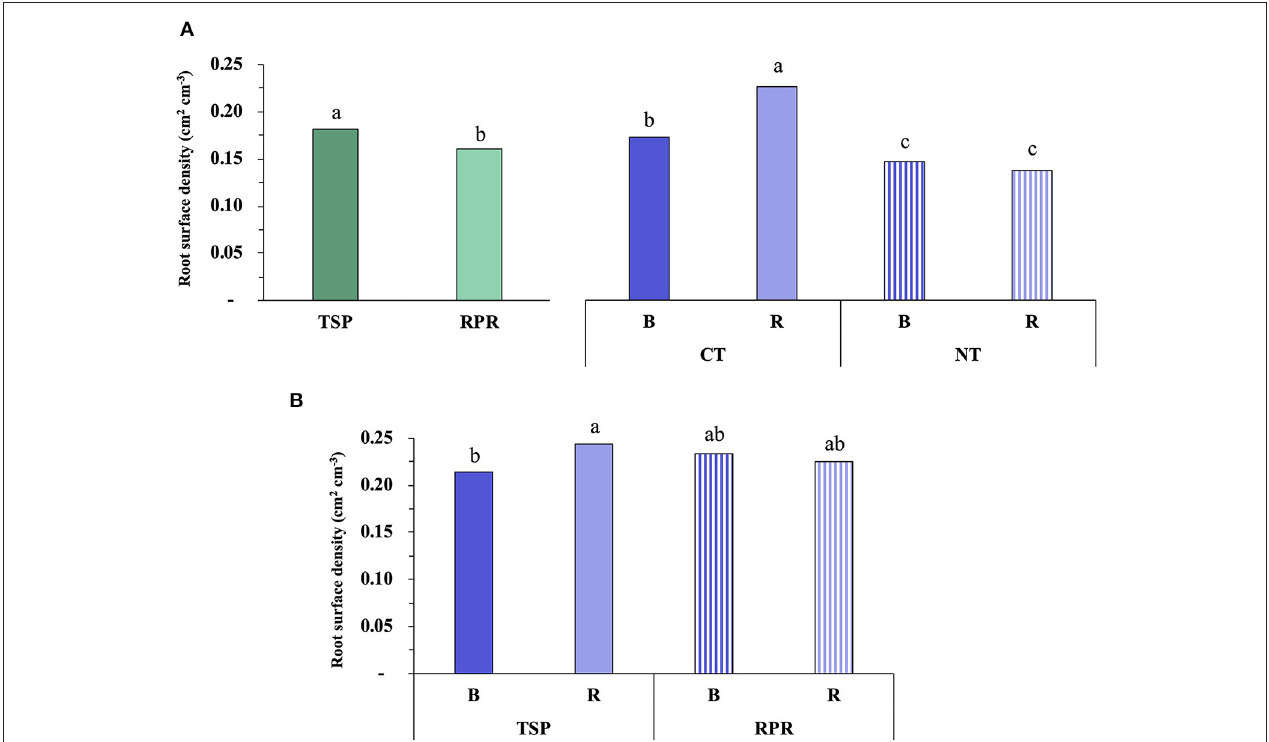
FIGURE 4 | Surface density of soybean (A) and corn (B) roots in the 0–20cm layer of a very clayey Oxisol under different soil tillage systems and phosphate fertilization managements. Letters compare levels of P source factor in (A) (green) and within 2-factor interactions in the remaining plots according to the LSD test (P < 0.05). NT, no tillage; CT, conventional tillage; TSP, triple superphosphate; RPR, reactive phosphate rock; B, broadcast; R,